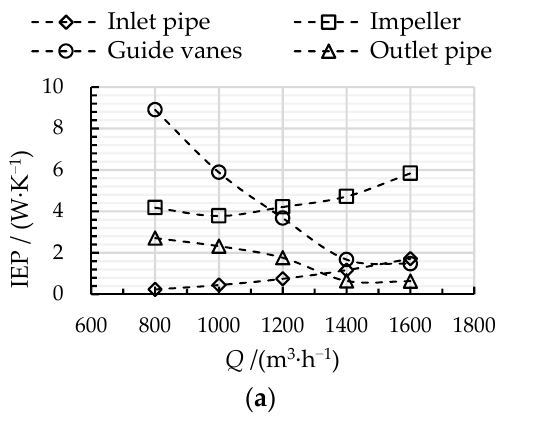
Figure 7. The distribution of ( a ) IEP and ( b ) DEP in mixed-flow pumps with guide vanes.